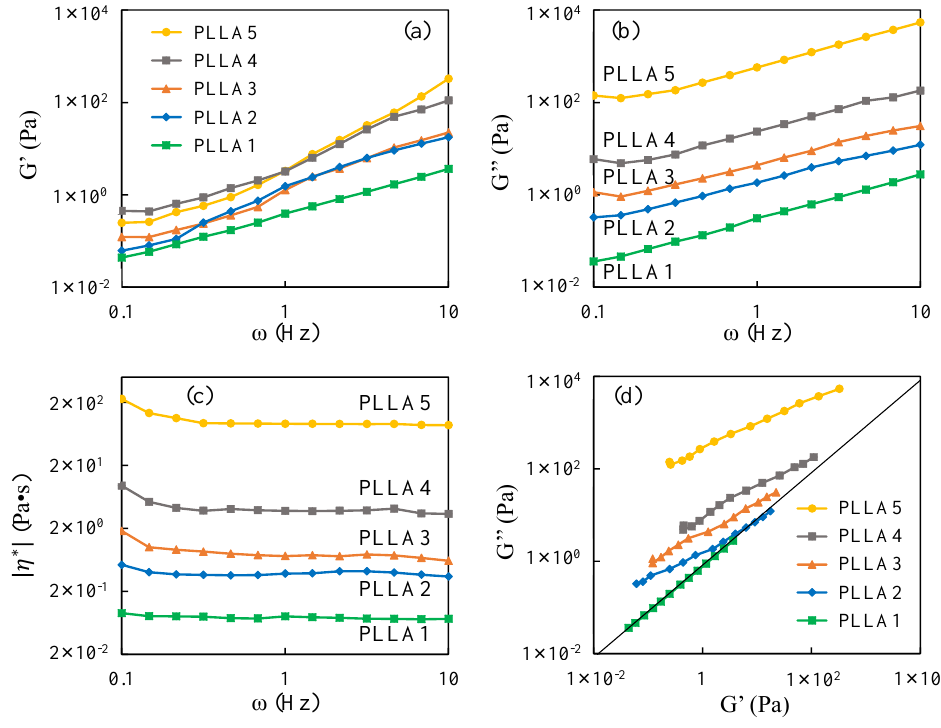
Figure 7. The dynamic frequency scanning curves of five PLLA samples at 190 °C: ( a ) storage modulus G ′ vs. frequency ω ; ( b ) loss modulus G ″ vs. frequency ω ; ( c ) complex viscosity |η ∗ | vs. frequency ω ; ( d ) storage modulus G ′ vs. loss modulus G ″ .